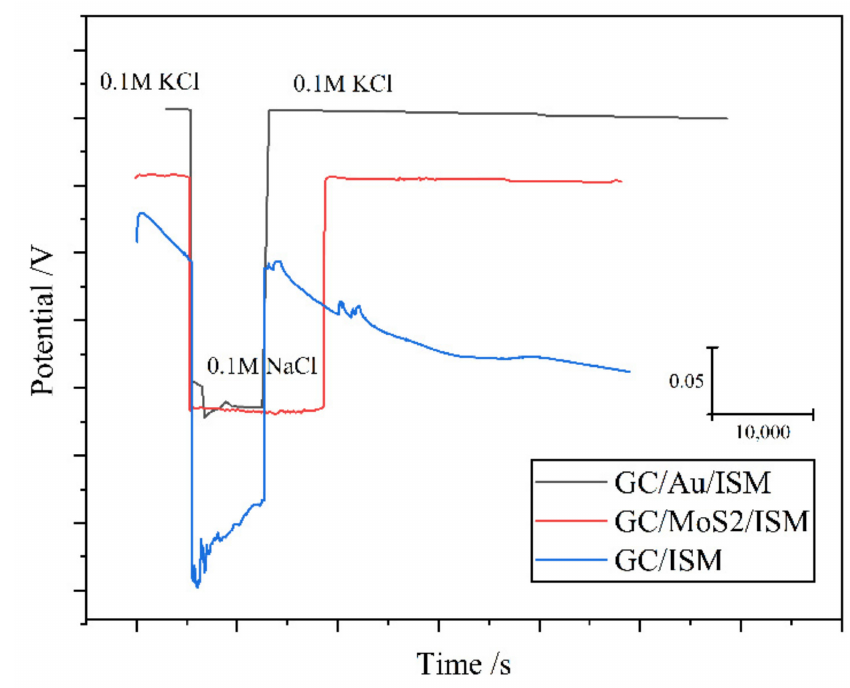
Figure 4. Diagram of water-layer test [56,57] (GC/ISM stands for glass carbon electrode without SC, and is the author’s